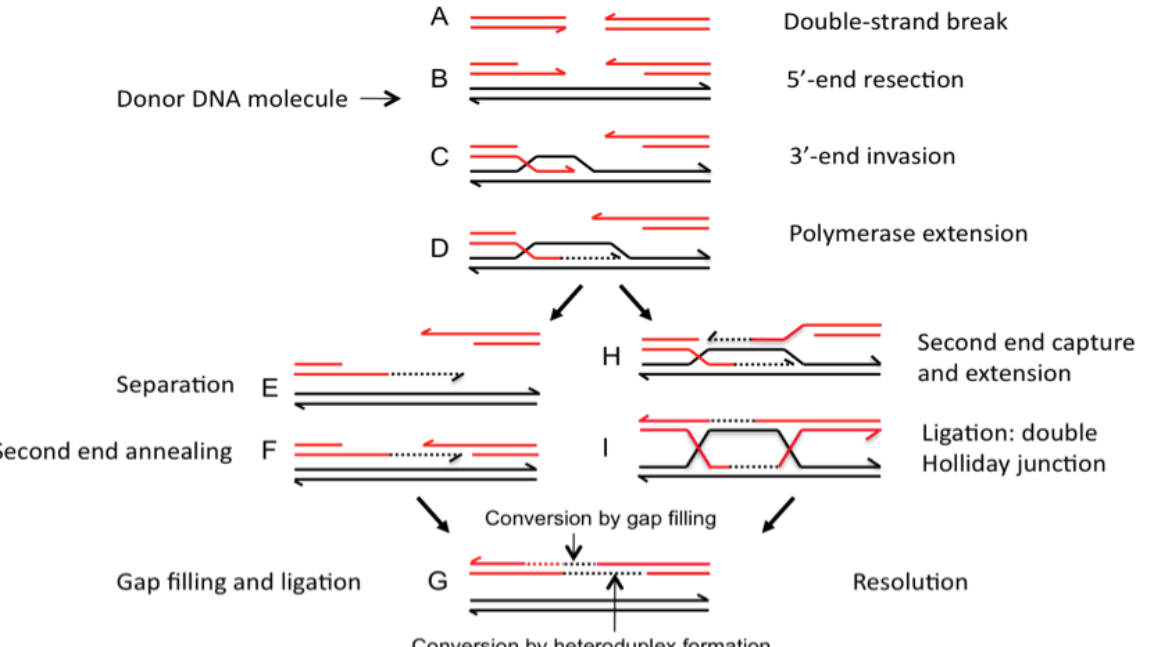
Figure 1. Mechanisms of gene conversion by double-strand break repair. The ends of a broken DNA molecule ( A ) are processed by exonucleolytic resection of the 5' end to give a 3' overhanging tail ( B ). This tail is coated by the Rad51 recombinase and then invades a homologous donor sequence forming a D-loop ( C ). The 3'-end in the D-loop primes DNA synthesis that copies the homologous sequence ( D ). At this point there are two different possible routes: In a pathway called synthesis-dependent strand-annealing (SDSA), the extended 3'-end is dissociated from the D-loop ( E ). It might then anneal to the 3' tail from the other side of the break, because the extended sequence is now complementary to that 3'-end ( F ). After gap-filling and ligation we are left with an unchanged donor molecule and a repaired molecule that carries sequence copied from the donor ( G ). Where the site of the original break was bridged, donor sequence is in both strands. Where sequence copied from the donor has annealed to the other 3'-end, there is heteroduplex, having one strand from the donor sequence and one from the damaged molecule. Resolution of heteroduplex is described in Figure 2. SDSA is the major mode of recombinational repair of double-strand breaks in somatic cells. It does not lead to crossing over. In an alternative process called the double Holliday junction pathway, the 3'-end from the other side of the break anneals to the displaced strand in the D-loop ( H ), generating a double Holliday junction ( I ). As shown, the double Holliday junction can be resolved by endonuclease or by helicase and topoisomerase to give the same non-crossover configuration (G). Alternatively, the double Holliday junction can be resolved endonucleolytically to form a cross-over (not shown). Each line represents a nucleotide chain or strand of DNA. The damaged molecule is shown as red and the donor (undamaged) molecule, as well as sequences copied from it, are shown in black. New DNA synthesis is shown as dotted lines. Polarity is indicated by half arrows on 3' single-strand